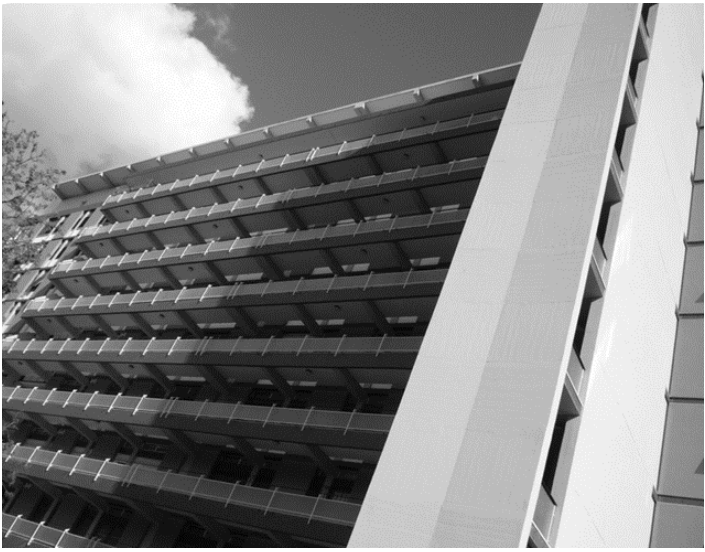
Figure 13. Rear façade. The stairs of the building and the galleries.